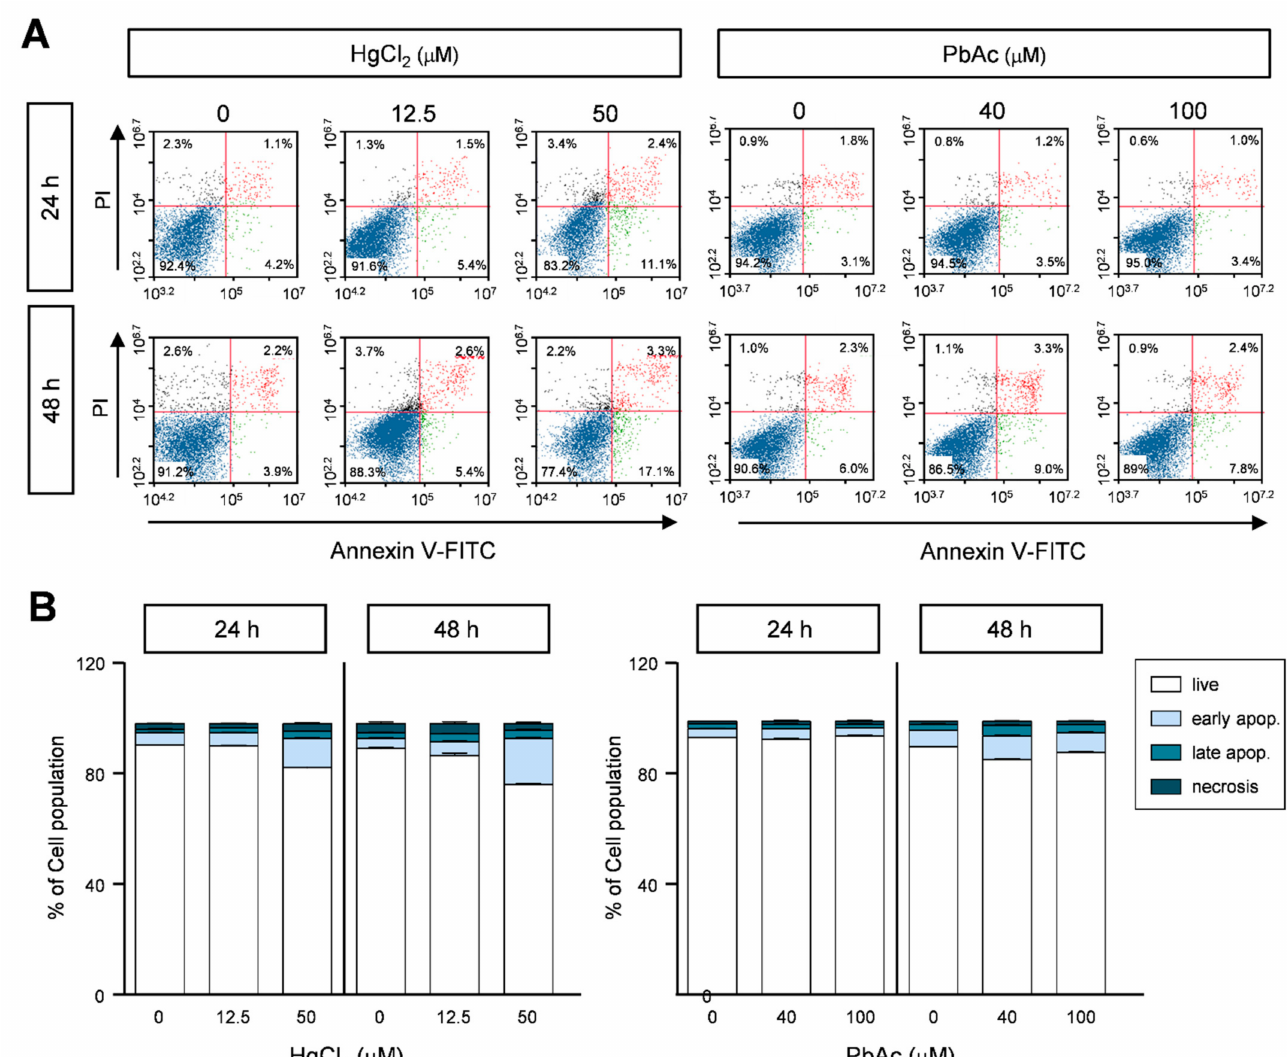
Figure 6. Effect of apoptotic cell death upon heavy metals treatment in MRC5 cells. ( A ) Cells were treated with indicated concentration of heavy metals for 24 or 48 h, and were double-stained with annexin V-FITC and PI. The proportion of apoptotic cells was assessed by FACS analysis. The scatter plots represent PI (Y-axis) and annexin V-FITC (X-axis). ( B ) The percentages of cells in the live, early- and late-apoptotic, and necrotic stages are expressed as the mean ± S.E.M. of three independent experiments (n = 6), each performed in